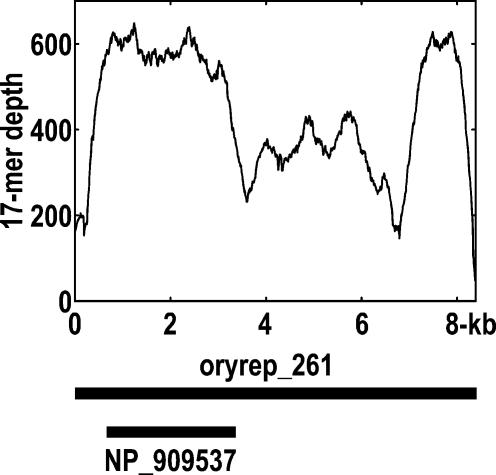
Recovery of Unknown TEAlthough not found in Repbase, we believe that this ReAS TE is a valid reconstruction, because it has a BlastX match with identity 98% over 869 amino acids to a TE-related protein (gi|34896386|ref|NP_909537.1| Putative mutator like transposase) that is annotated in a GenBank clone.